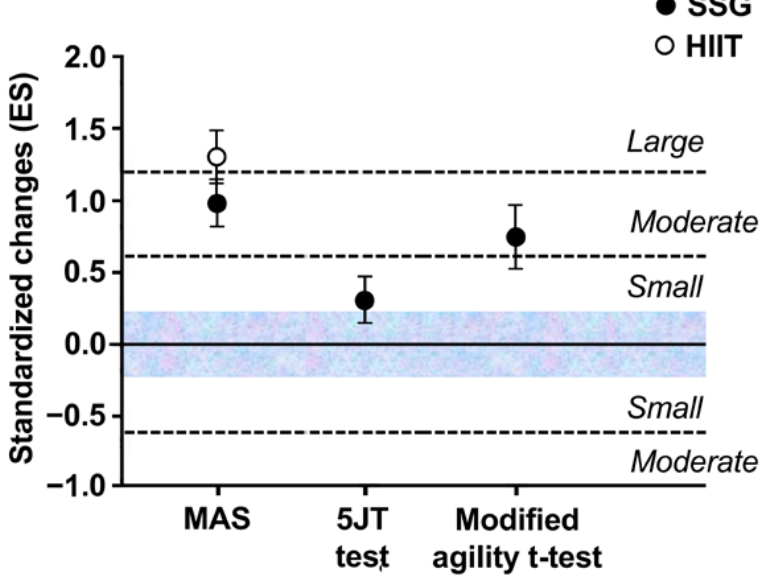
Figure 5. Relationships and sensitivities of Maximal aerobic speed (MAS), 5JT test and modified agility t -test to six-week high intensity interval (HIIT) or small-sided games (SSG) training program.